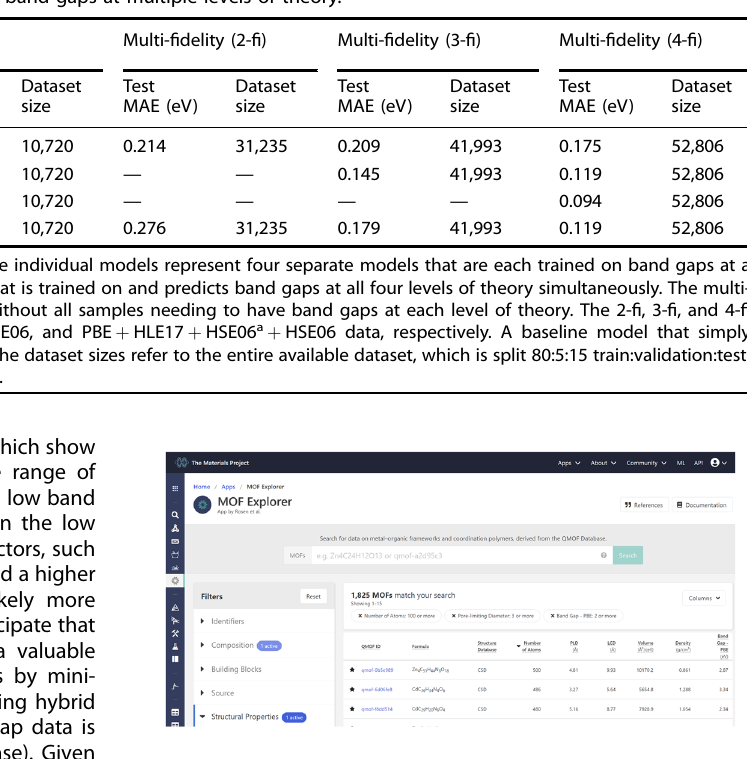
Fig. 6 Screenshot of the Materials Project MOF Explorer interface to the QMOF Database. Representative snapshot of the current search interface to the MOF Explorer application on the Materials Project with an example multi-query search